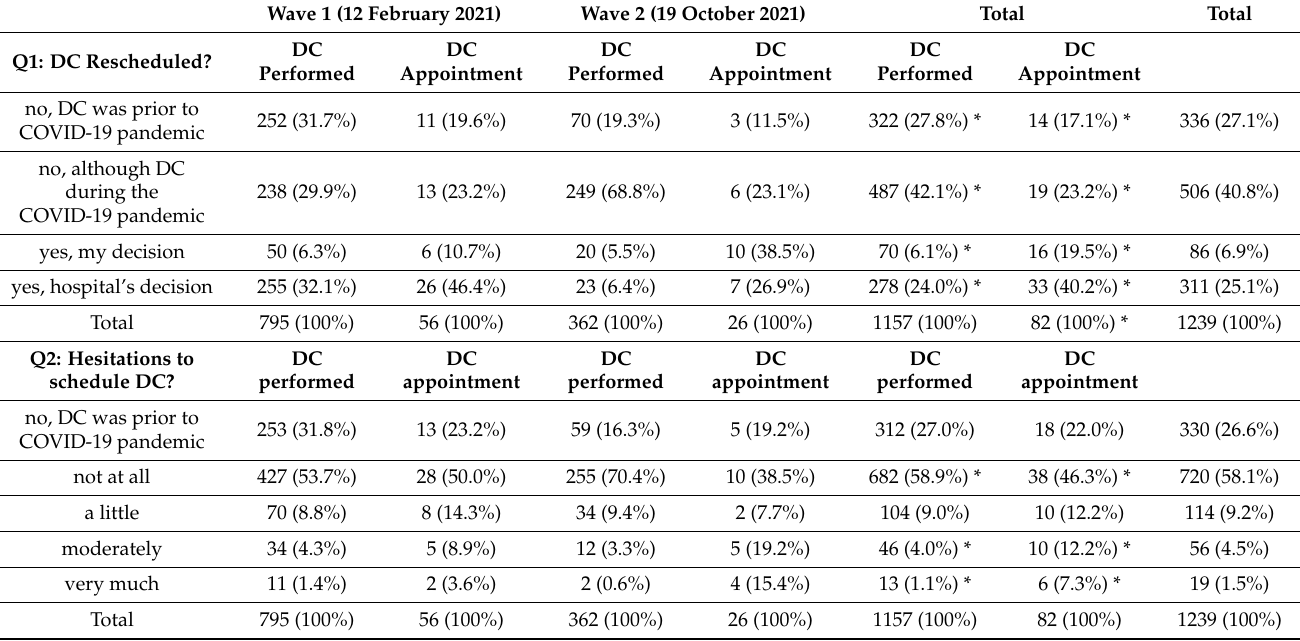
Table 3. Survey question results of groups DC performed and DC appointment at the time of the survey (according to survey waves), in absolute numbers and